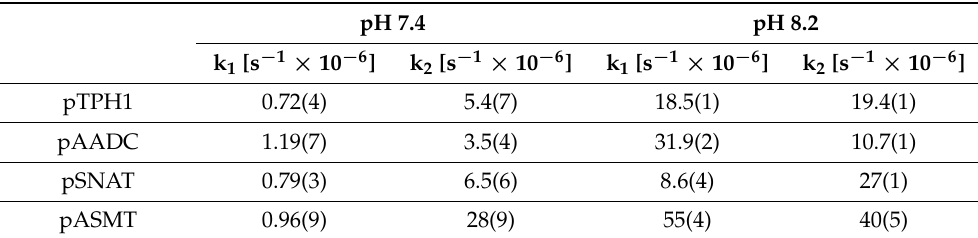
Table 3. Apparent first-order rate constants determined for Ni(II)-assisted peptide bond hydrolysis at 37 ◦ C a